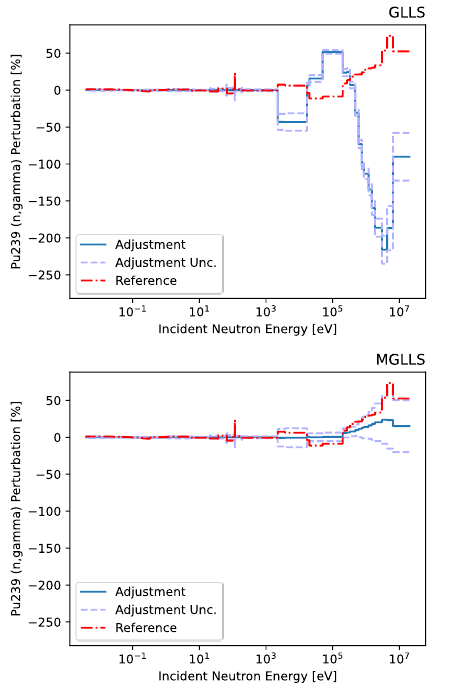
Fig. 6 Comparison of adjusted nuclear data #5